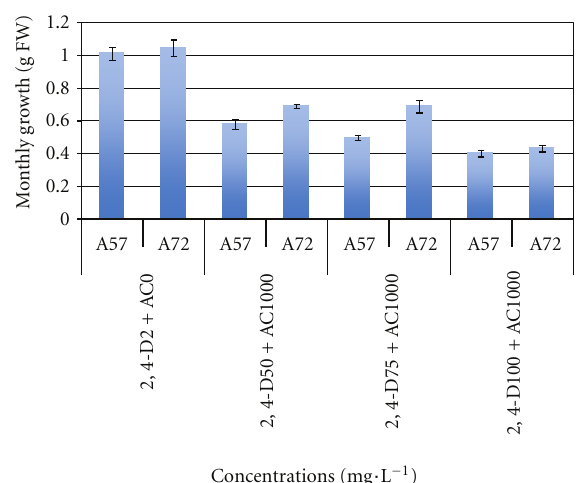
Figure 3: E ff ect of 2,4-D (2 mg/L) without activated charcoal (AC) or at 50, 75, and 100 mg/L with AC (1000 mg/L) on growth rates of suspension cultures from two di ff erent Ahmar cultivars lines. Averages values were calculated from 5 repetitions per condition of medium; bars indicate confidence interval at 95%